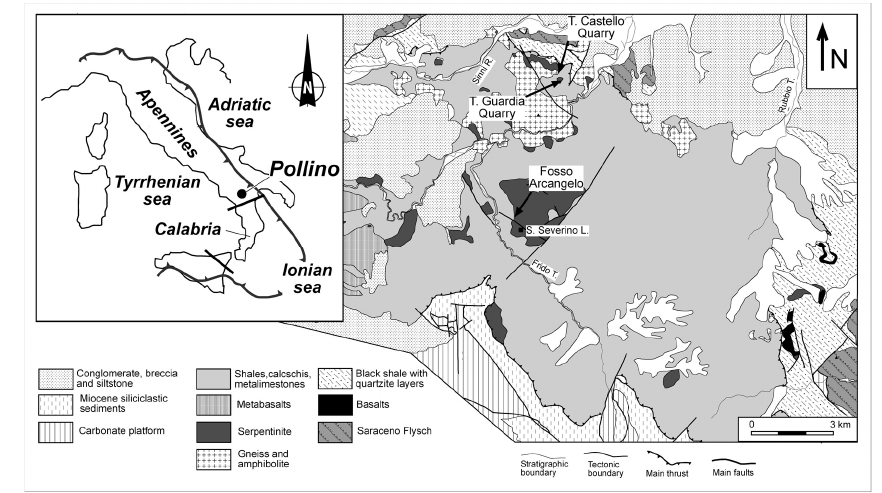
Figure 1. Geological sketch map of the southern Apennines and location of the study